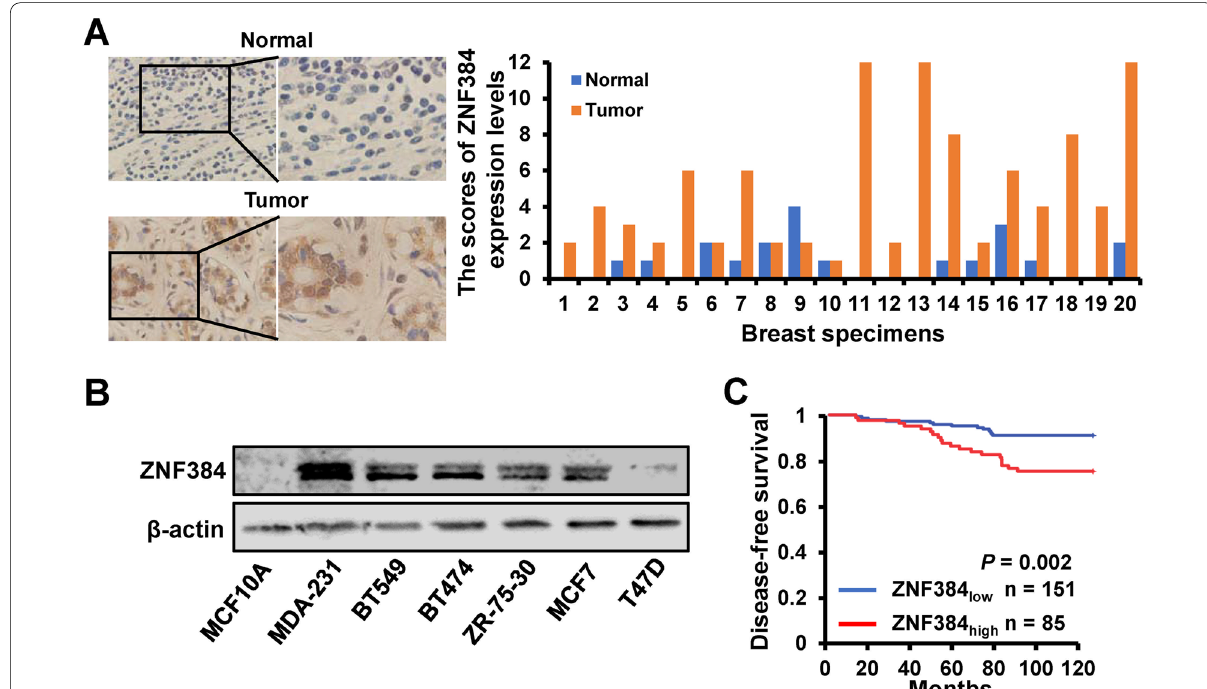
Fig. 1 ZNF384 is highly expressed in breast cancer and associated with poor prognosis. A ZNF384 expression determined by IHC in 20 cases of primary breast cancer tissues and the paired normal breast tissues. B ZNF384 expression in six breast cancer cells and the normal breast cell line MCF10A determined by western blot. C The Kaplan–Meier analysis of disease‑free survival of patients with different ZNF384 expression levels (n =